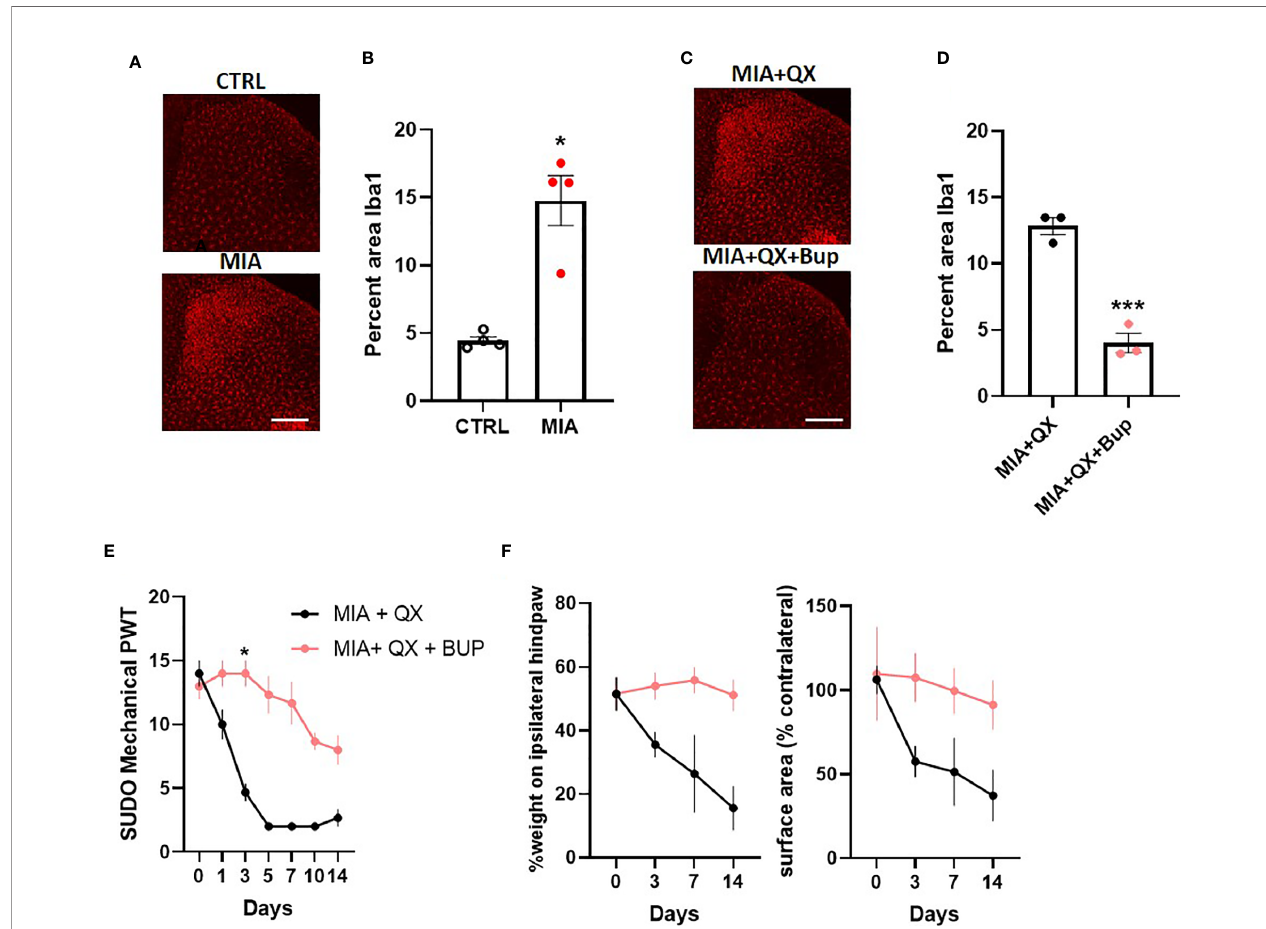
FIGURE 5 | Peripheral joint in fl ammation induced mechanical allodynia is alleviated by pharmacological silencing of primary afferents in female rats. (A) Representative image of Iba1 immunoreactivity in the ipsilateral dorsal horn two weeks after MIA injections into the knee joint, and after co-administration of QX-314 (QX, 2%/25 m L) and bupivacaine (Bup, 10 m g/25 m L). Scale bar = 200 m m. (B) Quanti fi cation of Iba1 immunoreactivity at two weeks after MIA injections. (N=4 animals per group). (C) Representative image of Iba1 immunoreactivity in the ipsilateral dorsal horn at two weeks post-MIA after QX+Bup co-administration. Scale bar = 200mm. (D) Quanti fi cation of Iba1 immunoreactivity at two weeks after MIA and QX+Bup injections (N=3 animals per group). (E) Mechanical withdrawal thresholds after MIA + QX and MIA with QX+ Bup, animals receiving QX alone after MIA injections developed signi fi cant mechanical allodynia, which was rescued by co-administration of QX and Bup (N=3 animals per group). (F) Effects QX and Bup co-administration on dynamic weight bearing behaviours after MIA injections (N=3 animals per group). *P < 0.05, ***P <